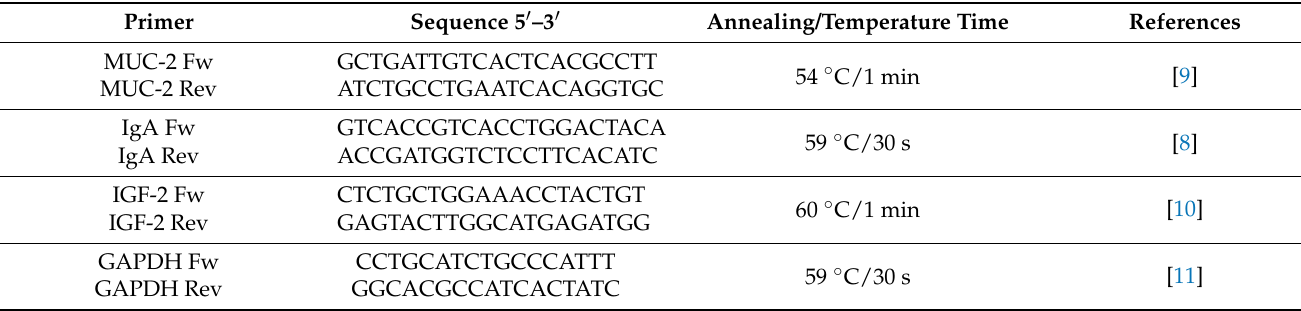
Table 3. List of primers used for the chicken cytokine mRNA quantification. Primer Sequence 5 (cid:48) –3